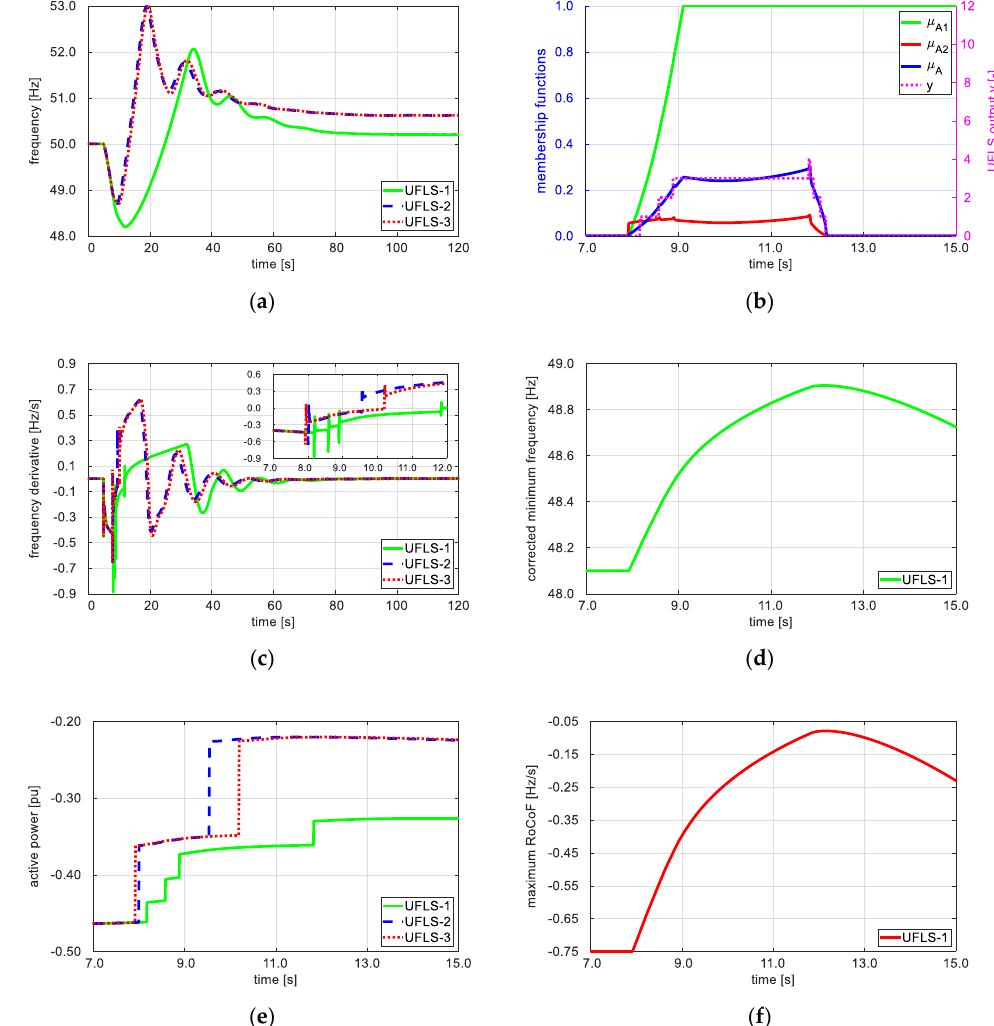
Figure 6. Time variation of selected variables during the unloading process—Case B: ( a ) frequency, ( b ) membership functions and UFLS output y , ( c ) frequency derivative (RoCoF), ( d ) corrected minimum frequency f * min , ( e ) active power disconnected, ( f ) maximum RoCoF f (cid:48)∗ max .